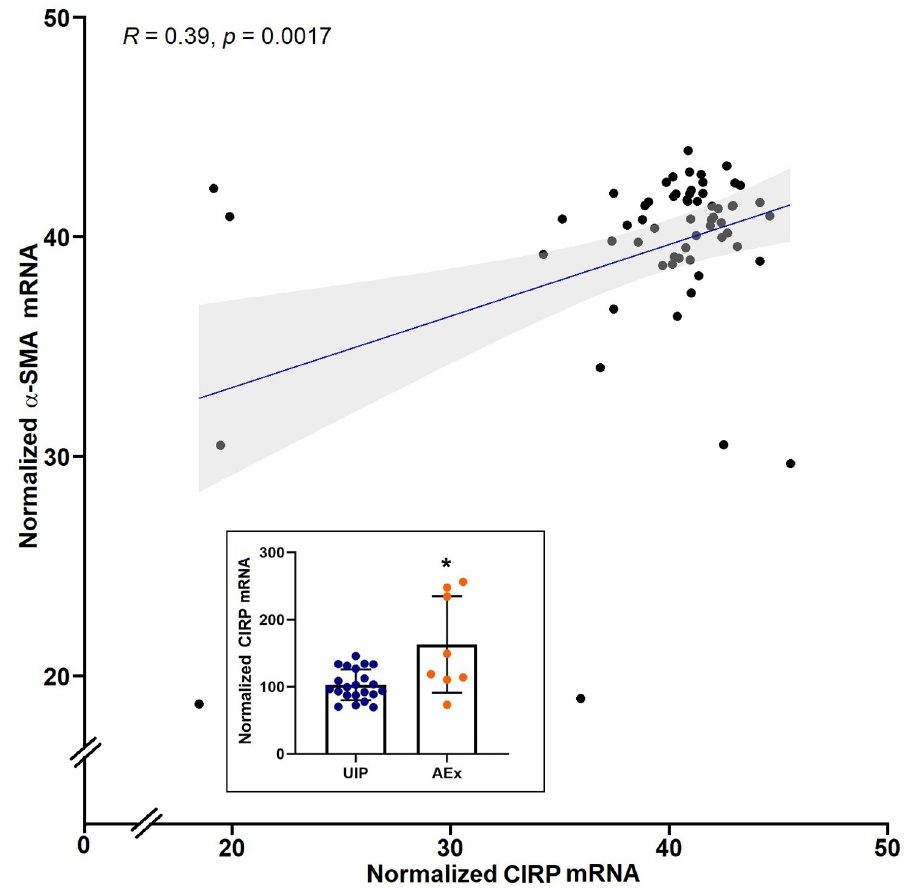
Fig 1. CIRP mRNA expression correlates with α -SMA in IPF patients and is increased during acute exacerbation of IPF. Examinations of two publicly available gene expression omnibus (GEO) profiles: GSE98925 and GSE10667 (insert): After obtaining mRNA expression data using the getGEO function, expressions were normalized across all samples using the package limma workflow. The figure shows Pearson correlation and the coefficient (R = 0.39) obtained between mRNA expression of CIRP and α -SMA, along with p-value (p = 0.0017) shown for GSE98925, which is the mRNA array profile of microdissection from multiple fibroblastic foci from the lung tissues of 13 IPF patients either from the biopsy or after lung explantation. The insert shows the difference between the normalized CIRP mRNA in stable IPF patients (UIP) vs. those with acute exacerbation of IPF (AEx) in data from GSE10667. Unpaired Student’s t-test was used to determine the significance. � p < 0.05 vs. UIP. The sample GSM269765 was removed due to normalized CIRP mRNA for that sample being more than 3 standard deviations away from the